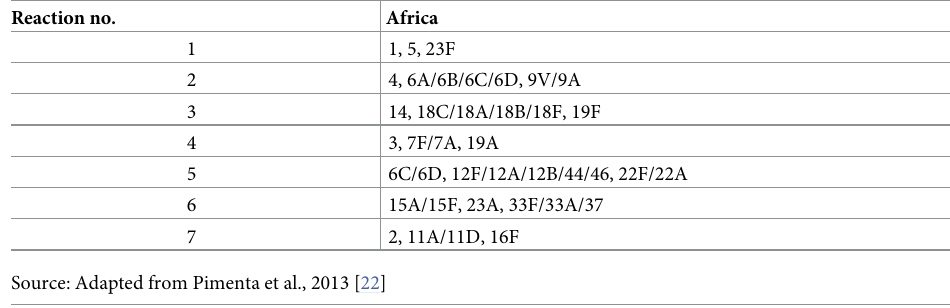
Table 1. Pneumococcal capsular serotypes/serogroups primers used in the African schemes. Reaction